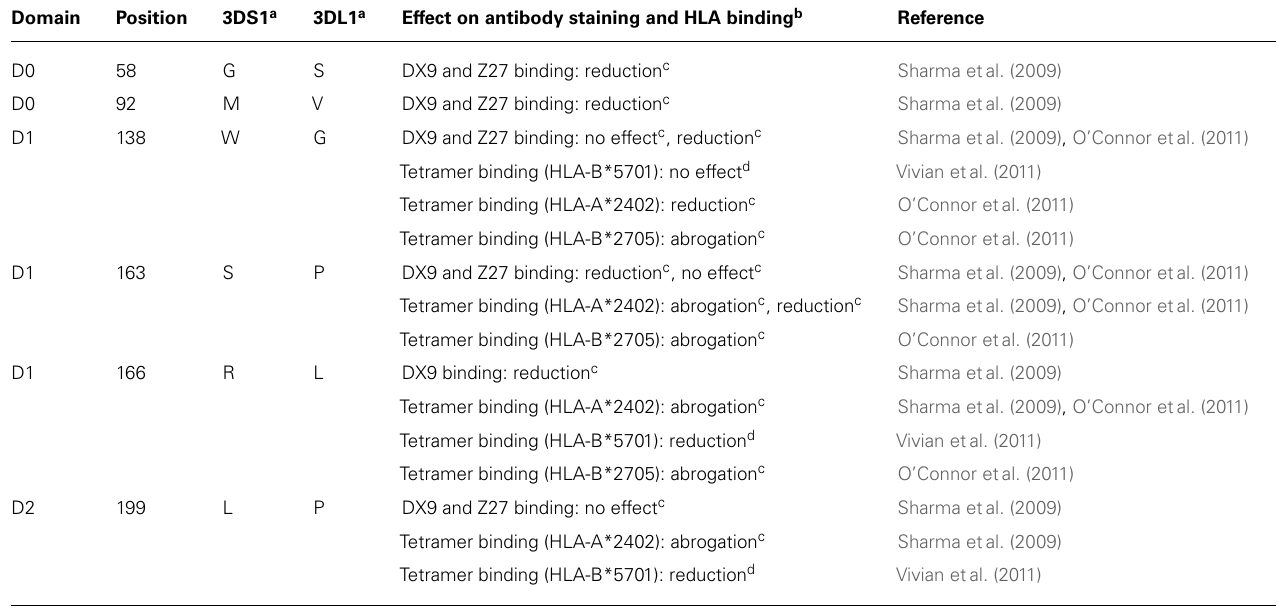
Table 1 | Effects of selected amino acid variations within KIR3DL1/S1 on antibody recognition and HLA